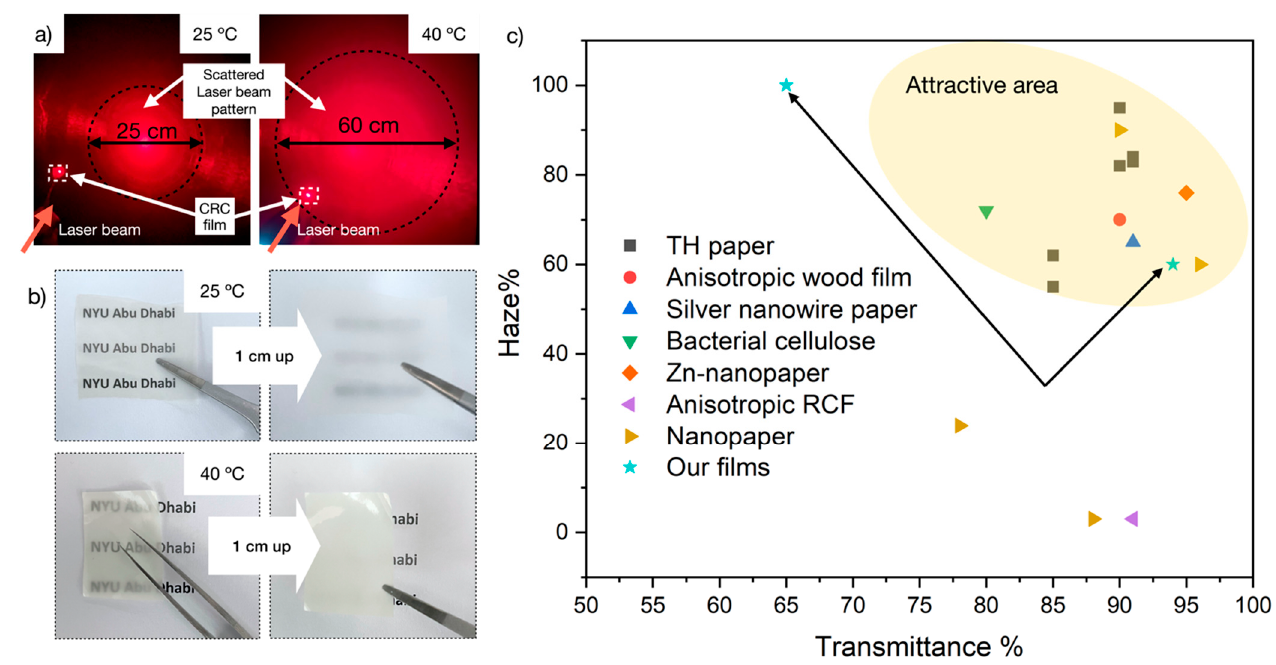
Figure 6. Optical properties of CRC cured at 25 and 40 °C. ( a ) Digital images of laser light pointed at and scattered from CRC films cured at 25 and 40 °C. ( b ) Transparent and hazy CRC films cured at 25 and 40 °C, in close contact with and 1 cm above letters written to represent the films’ light transmittance and haze. ( c ) Transmission haze vs. optical transmittance of our CRC films in comparison with other reported cellulose-based transparent and hazy films.